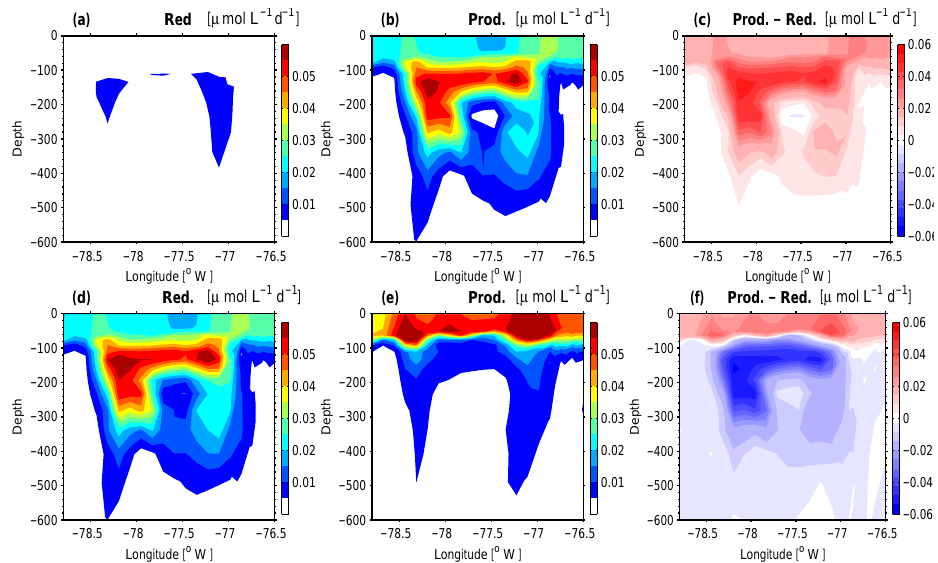
Figure 6. Eddy A sim vertical structure of (a) nitrate reduction by denitrification (µmolL − 1 d − 1 ), (b) nitrate production by nitrification (µmolL − 1 d − 1 ), (c) nitrate production-reduction difference (µmolL − 1 d − 1 ), (d) nitrite reduction (nitrification + denitrification + anammox, µmolL − 1 d − 1 ), (e) nitrite production (denitrification + nitrification, µmolL − 1 d − 1 ) and (f) nitrite production-reduction difference (µmolL − 1 d − 1 ) at the instant shown in Fig.